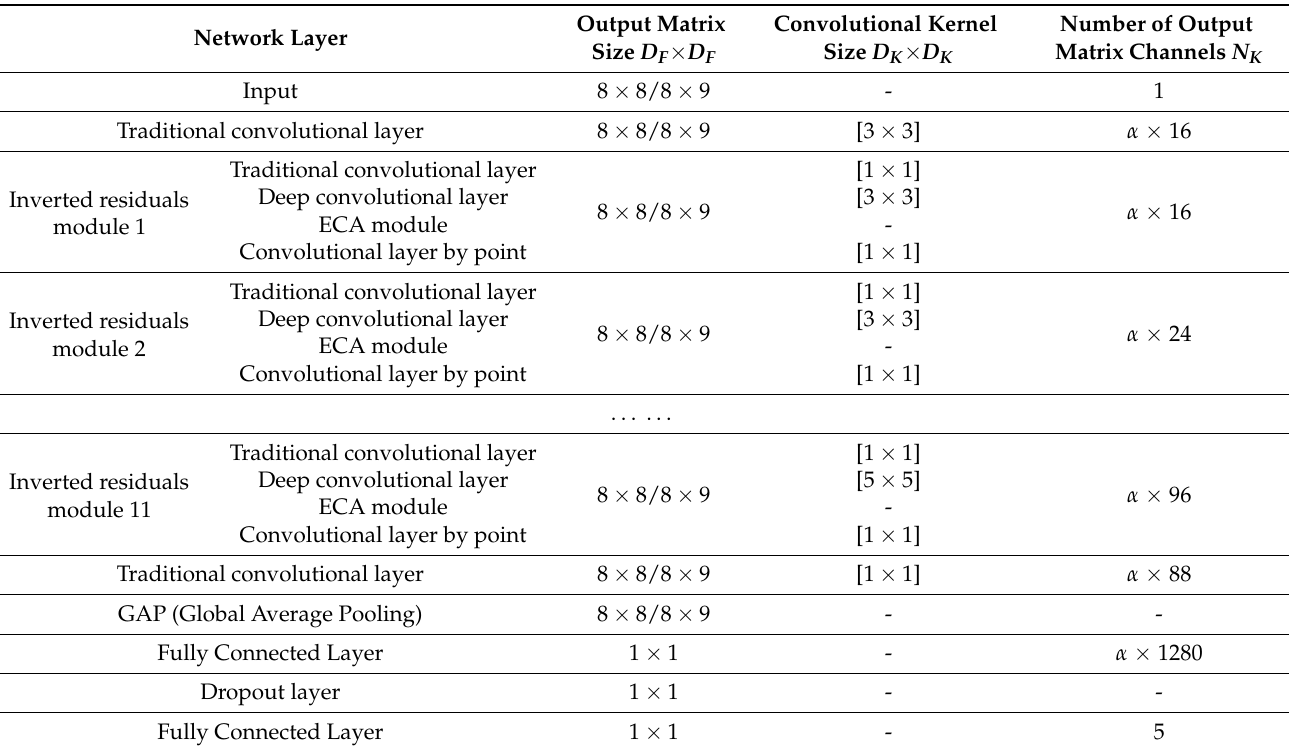
Table 1. Configuration table of the flight delay prediction model based on the ECA-MobileNetV3 algorithm. Network